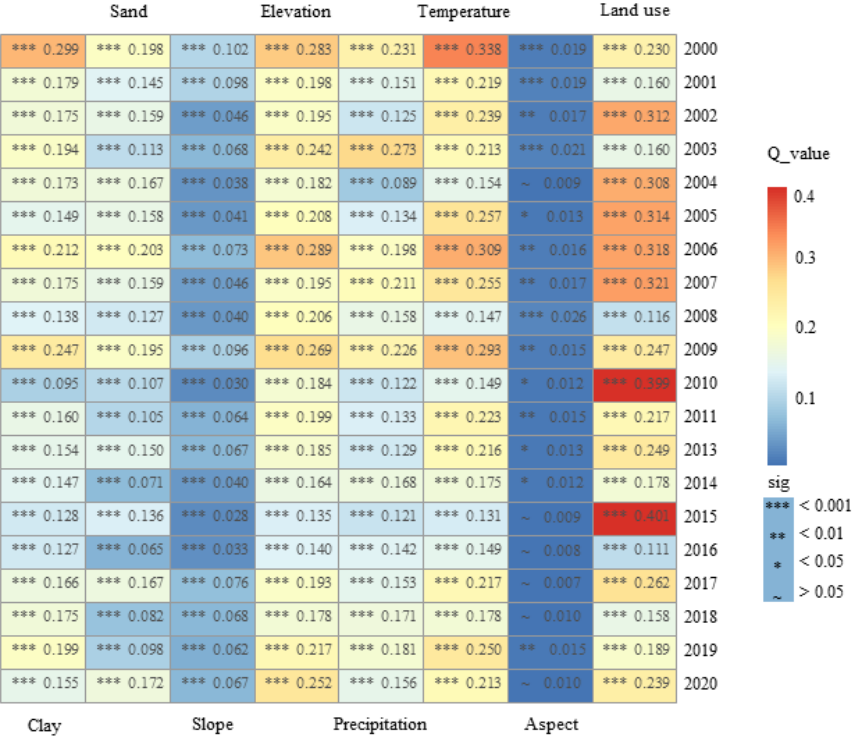
Figure 7. Q values of the FVC factor detector from 2000 to 2020.